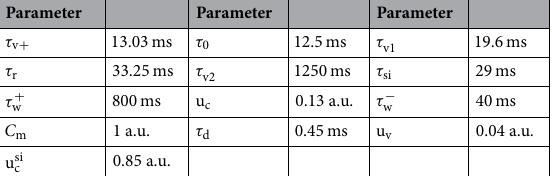
Table 5. The set of parameters used for simulations of the Fenton-Karma model.